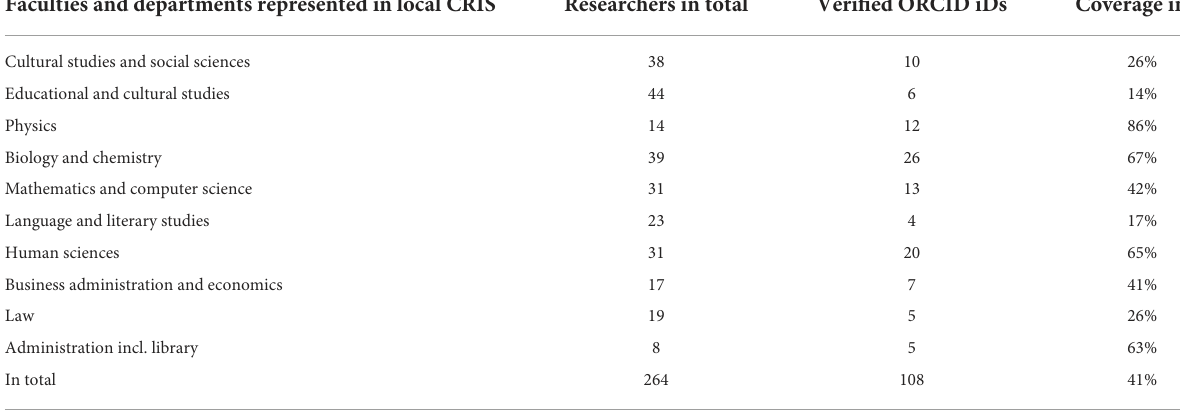
TABLE 2 Internal ORCID distribution by faculties and departments for